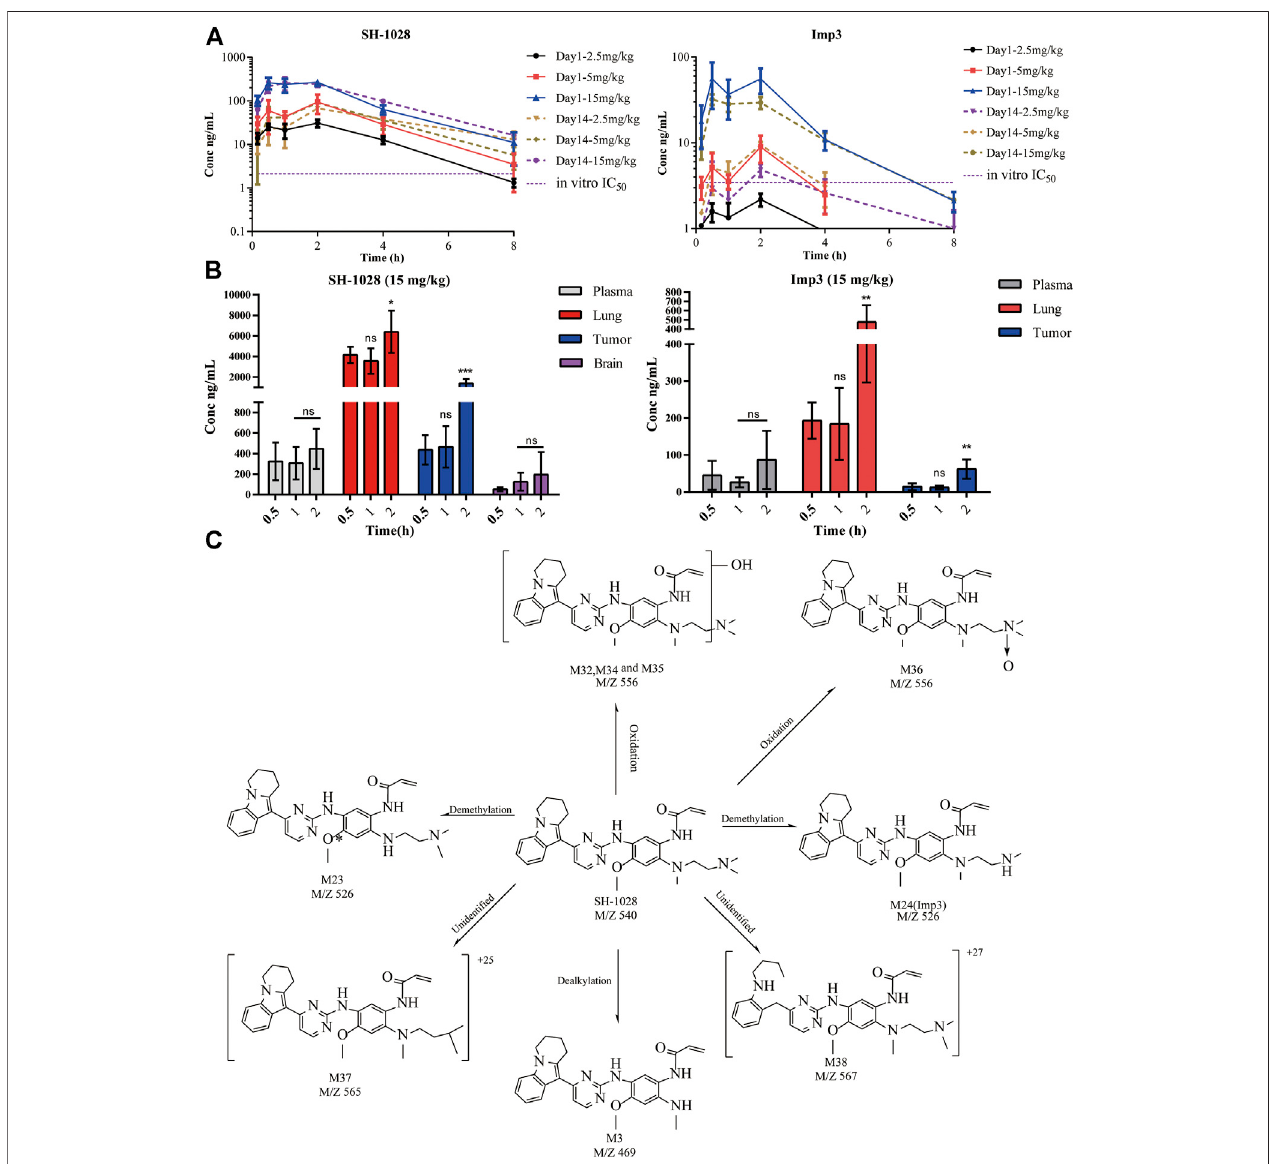
FIGURE4| ThepharmacokineticcharacteristicsofSH-1028.( A )SH-1028andImp3concentrationsinplasmafromSH-1028-treatedmiceondays1and14;p.o.: oral administration ( n (cid:1) 6). ( B ) SH-1028 and Imp3 concentrations in tissues from SH-1028-treated mice on days 1 ( n (cid:1) 6). ( C ) Proposed SH-1028 metabolic pathways and its major metabolites. Data were expressed as mean ± SD. * p < 0.05 vs. 0.5 h; ** p < 0.01 vs. 0.5 h; *** p < 0.001 vs. 0.5 h; ns: no signi fi cant difference vs. 0.5 h.